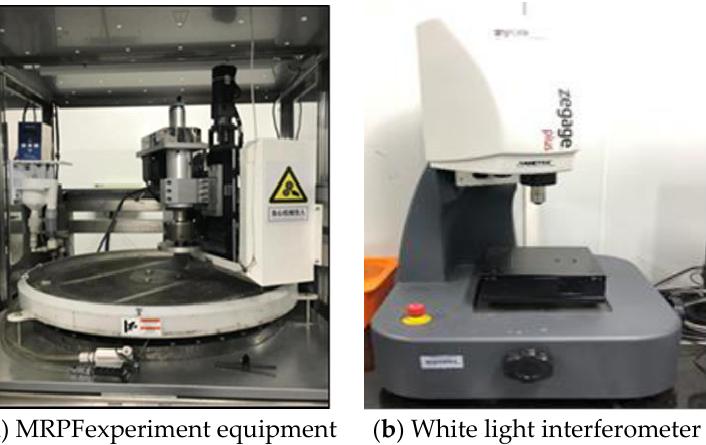
Figure 33. Experimental equipment.